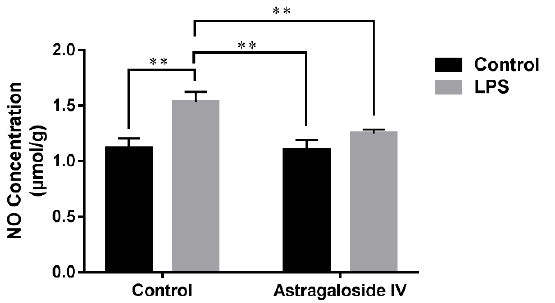
Figure 5. Effects of Astragaloside IV on the concentration of NO in LPS-induced uteri. The concentration of NO was determined at 24 h after LPS infusion. Two-way analysis of variance was performed with a Bonferroni post hoc multiple comparison test. Data are shown as mean ± SD. n = 6. **, p < 0.01.